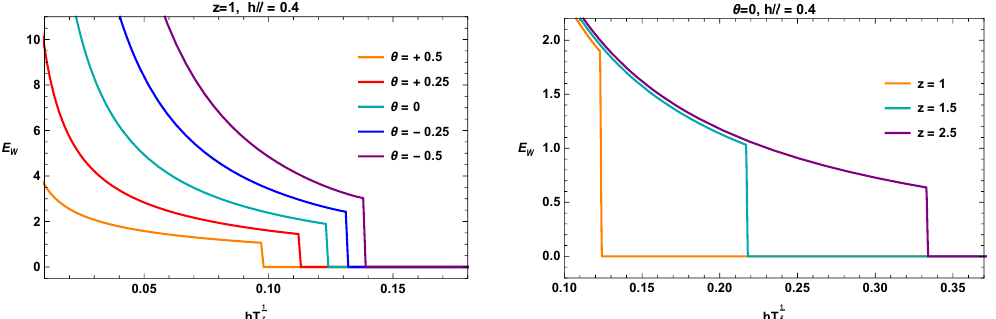
W decreases as (cid:18)